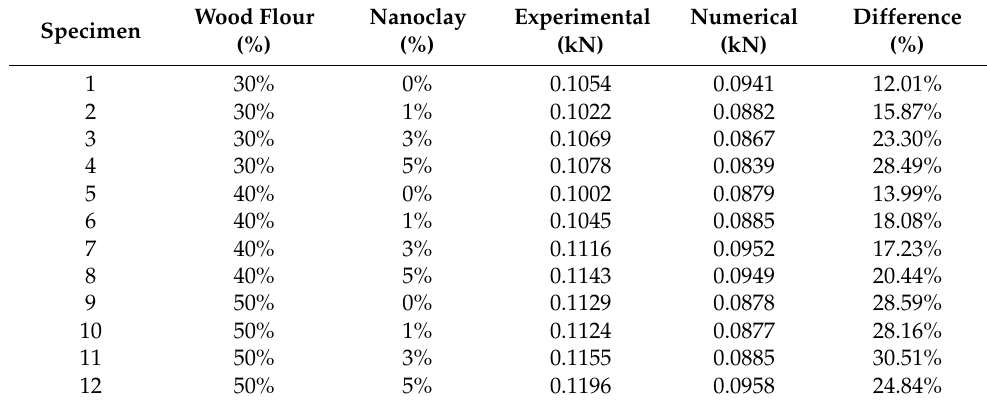
Table 11. Comparison of the failure force in the experimental and numerical bending test. Wood Flour Nanoclay Experimental Numerical Specimen (%) (%) (kN) (kN)